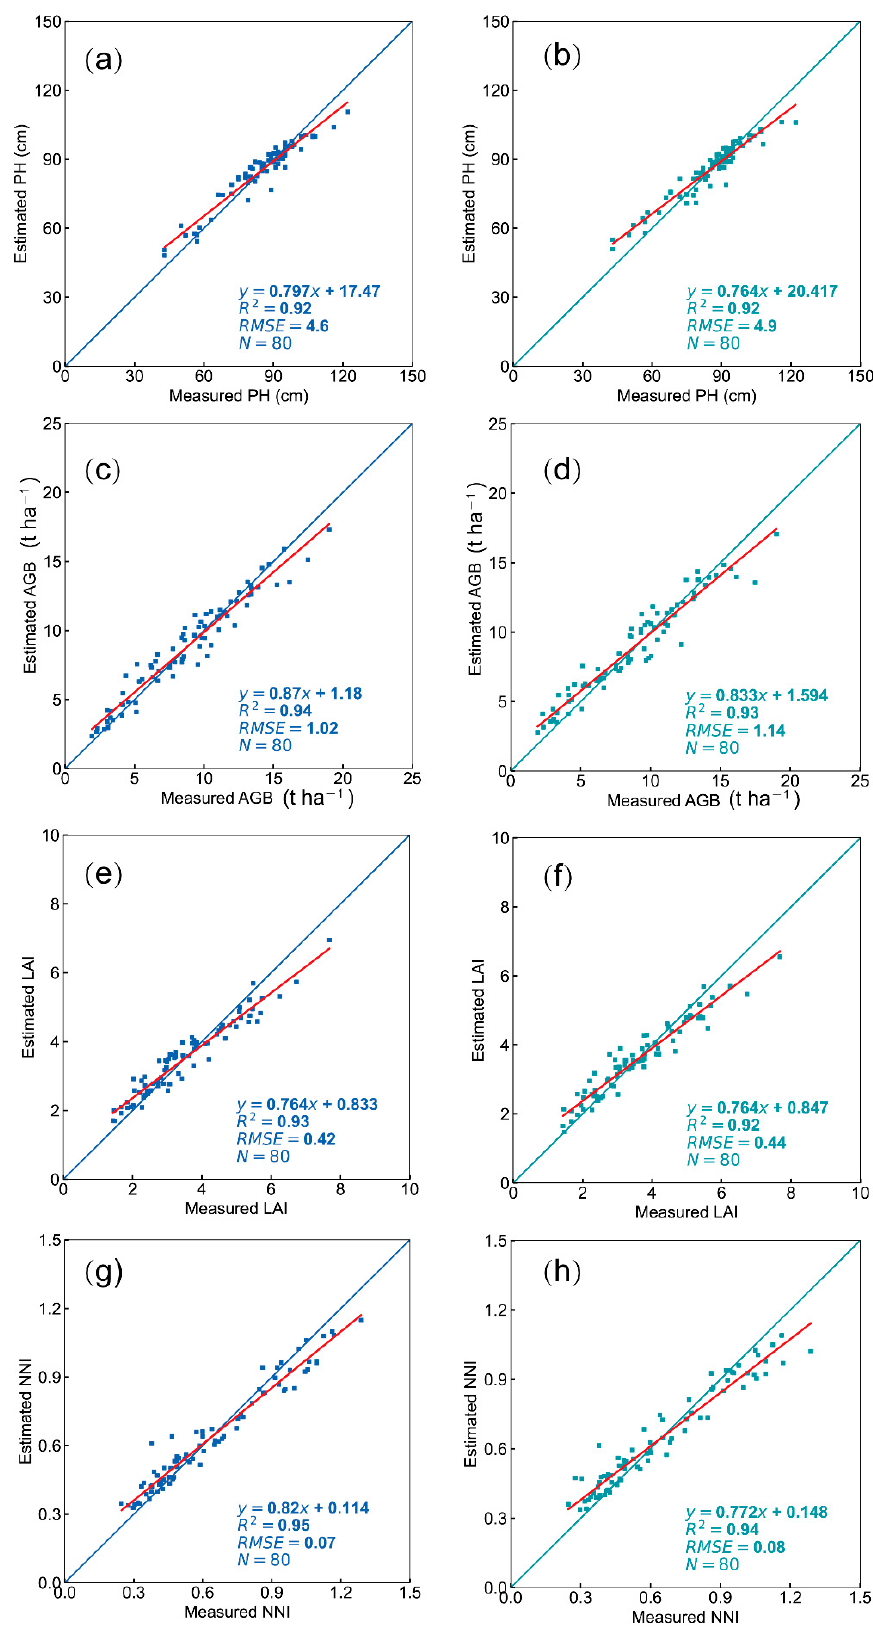
Figure 6. Validations of ( a , b ) pH, ( c , d ) LAI, ( e , f ) AGB, and ( g , h ) NNI with RF models based on VI from V images and V-NIR images, respectively, in full growth stage.